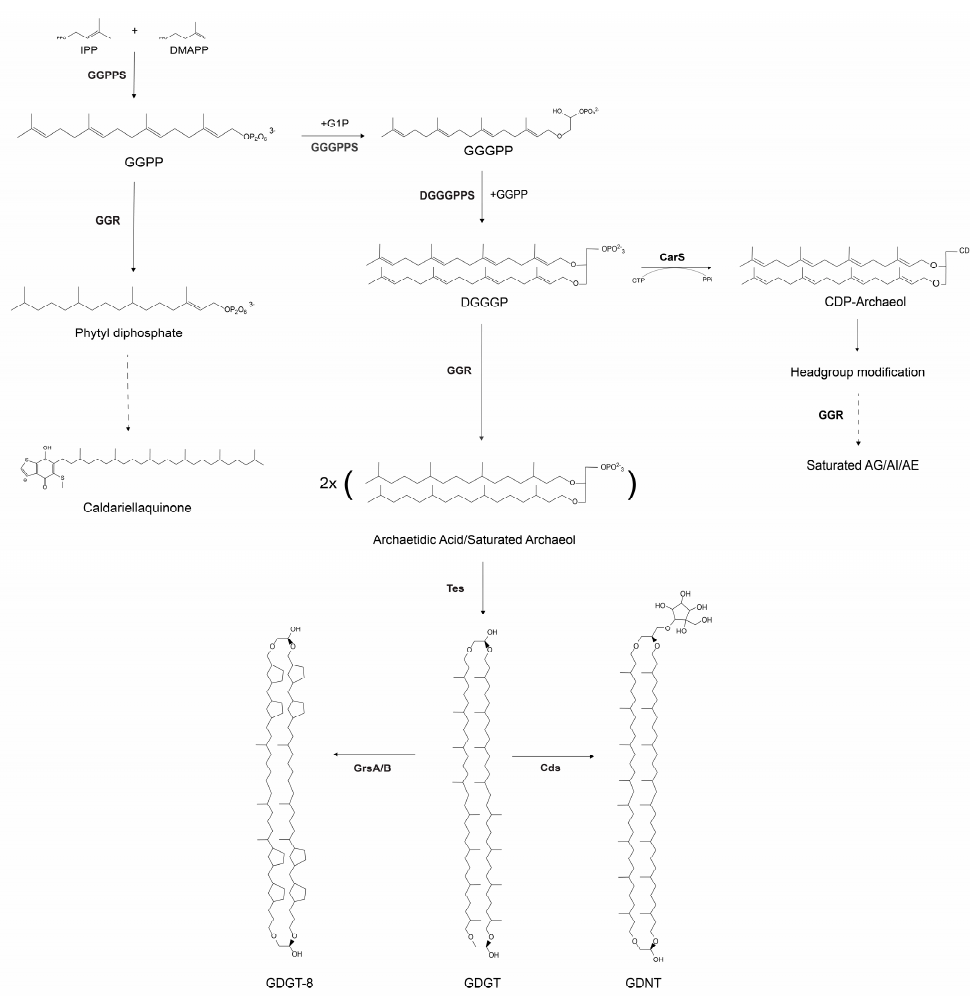
Figure 1. Schematic overview of the archaeal lipid biosynthesis pathway. The dashed arrows indicate a multi-step pathway that has not yet been characterized. AG-archaetidylglycerol, AE- archaetidylethanoamine,